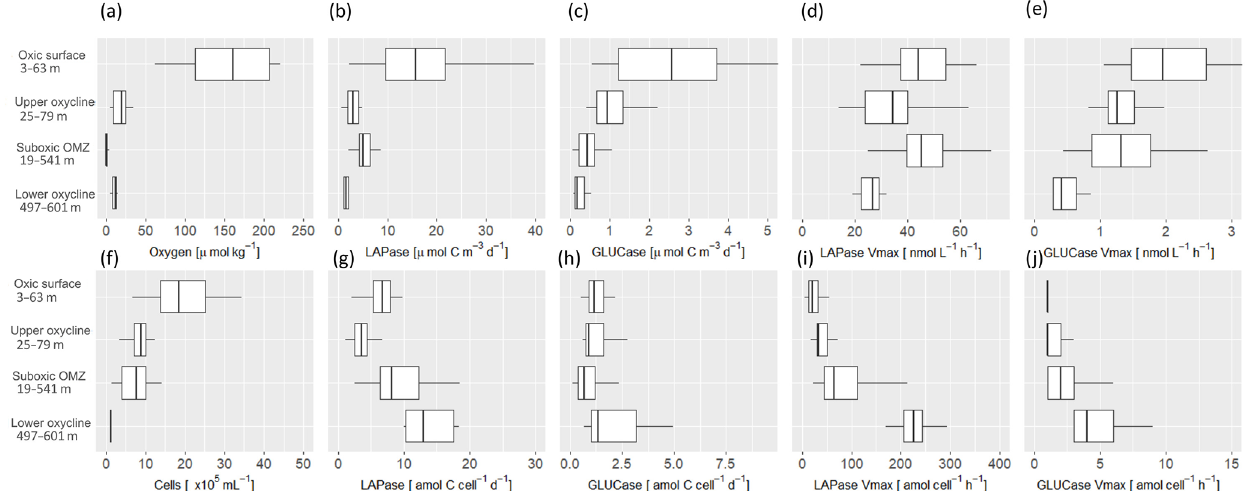
Figure 5. Extracellular enzyme rates at different in situ oxygen concentrations during April and June 2017 (M136, M138). Oxygen con- centrations (a) , degradation rates of dissolved amino acids (DHAA) by leucine-aminopeptidase (LAPase) (b) , degradation rates of high molecular-weight dissolved carbohydrates (DCHO) by β -glucosidase (GLUCase) (c) , total potential LAPase rates ( V max ) (d) , GLUCase V max (e) , cell abundance (f) , cell-specific degradation rates DHAA by LAPase (g) , cell-specific degradation rates of DCHO by GLUCase (h) , cell-specific LAPase V max (i) and cell-specific GLUCase V max (j) at different oxygen regimes off